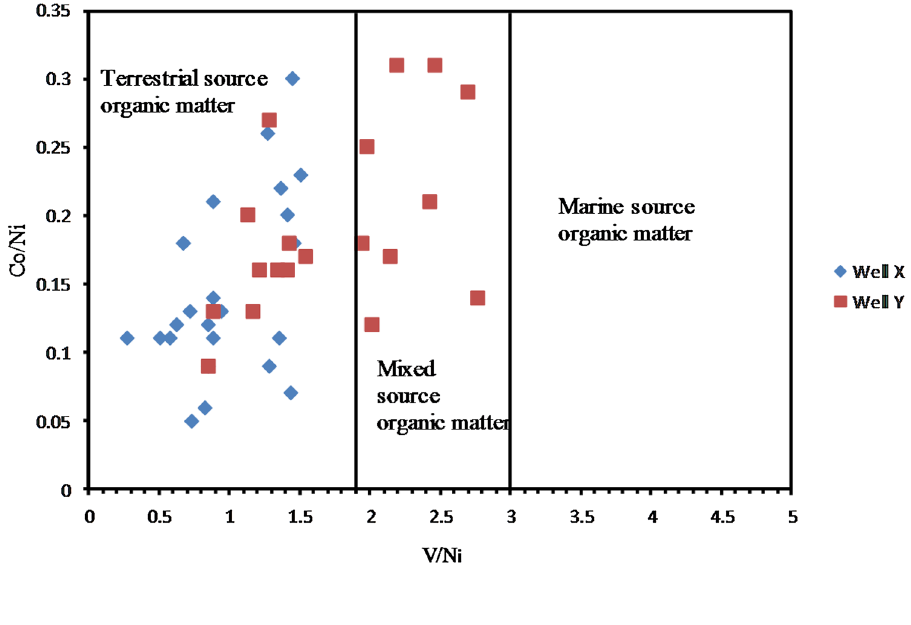
Fig. 7 Dendrogram cluster analysis of kerogen samples from the central Niger Delta using Co/Ni, V/(V + Ni) and V/ Ni as